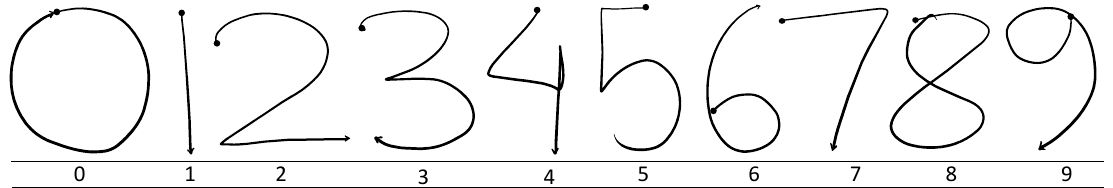
Figure 2. The digit writing order. The dot and the arrow symbol represent the starting and ending point, respectively.